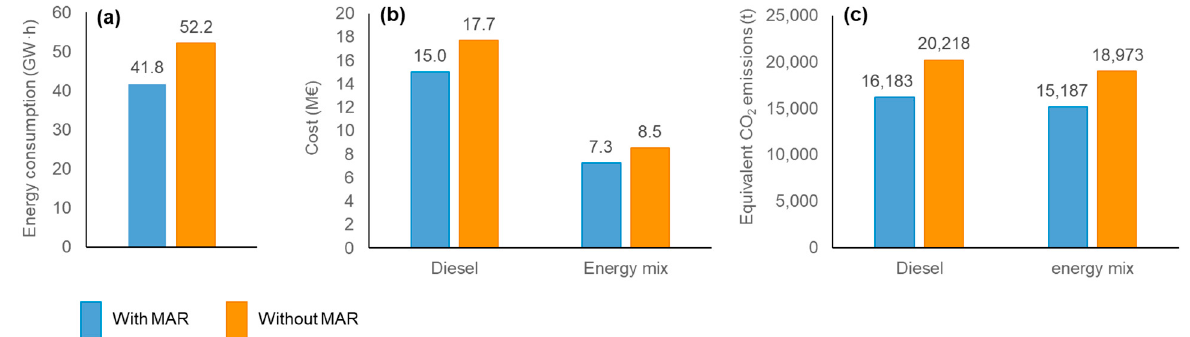
Figure 5. Groundwater pumping energy consumption, cost, and equivalent CO 2 emissions in the Los Arenales groundwater body (LAGB) in 2021 for the actual scenario, i.e., with managed aquifer recharge (MAR), and a hypothetical situation without MAR: ( a ) pumping energy consumption, ( b ) cost of pumping, and ( c ) equivalent CO 2 emissions generated by groundwater